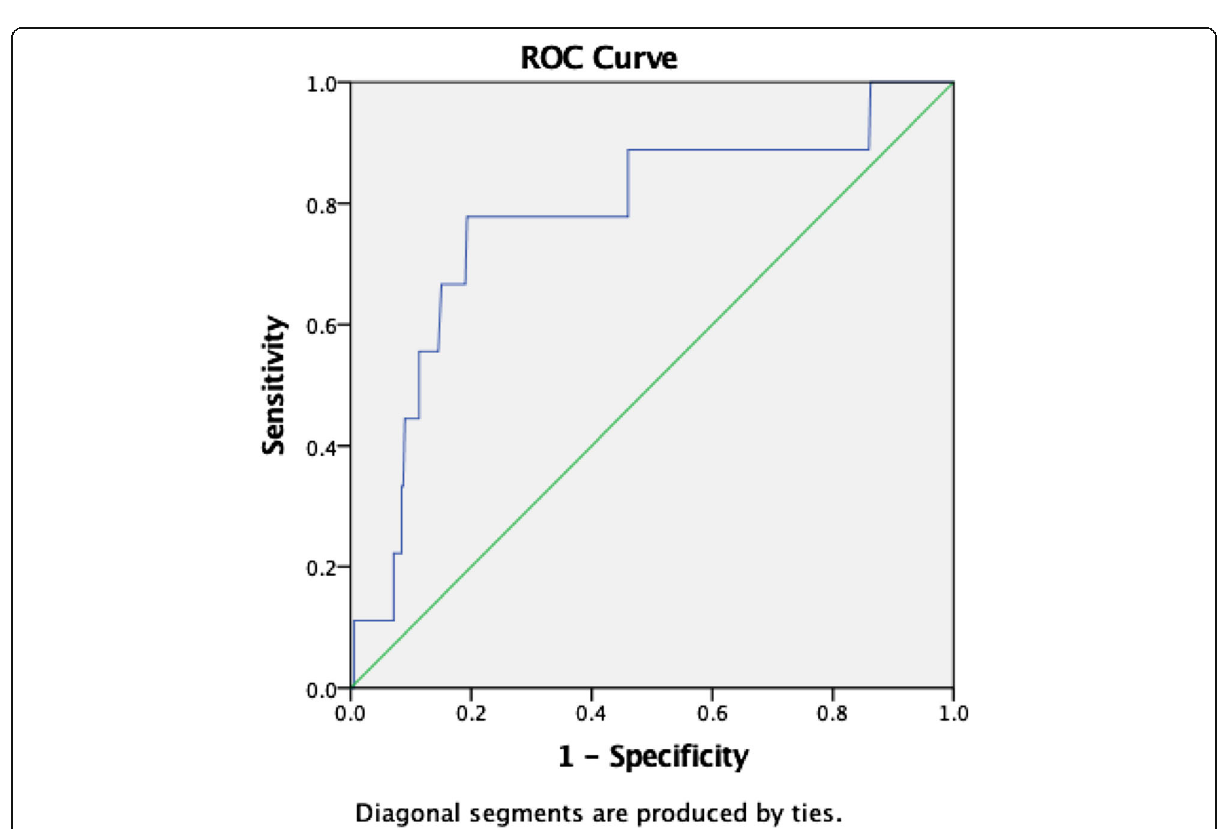
Fig. 4 Graphic representation of ROC curves for cardiac